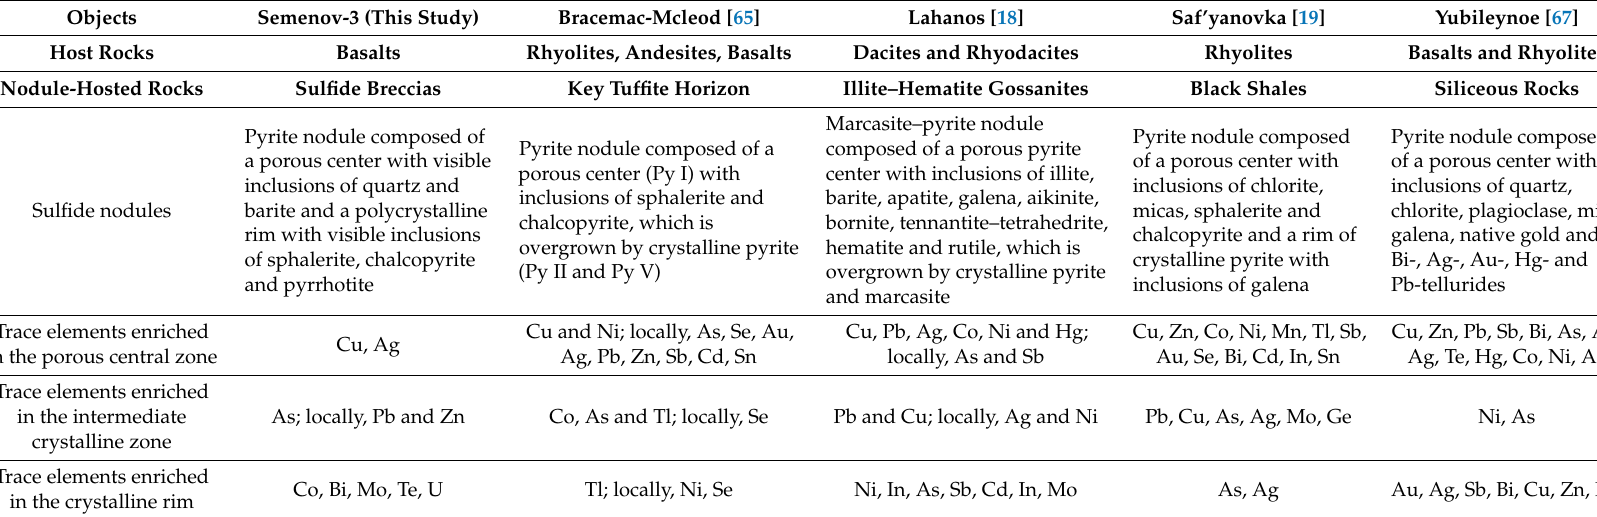
Table 6. Comparative features of sulfide nodules from the Semenov-3 hydrothermal field, Mid-Atlantic Ridge (MAR), and fossil volcanic-hosted massive sulfide (VHMS)